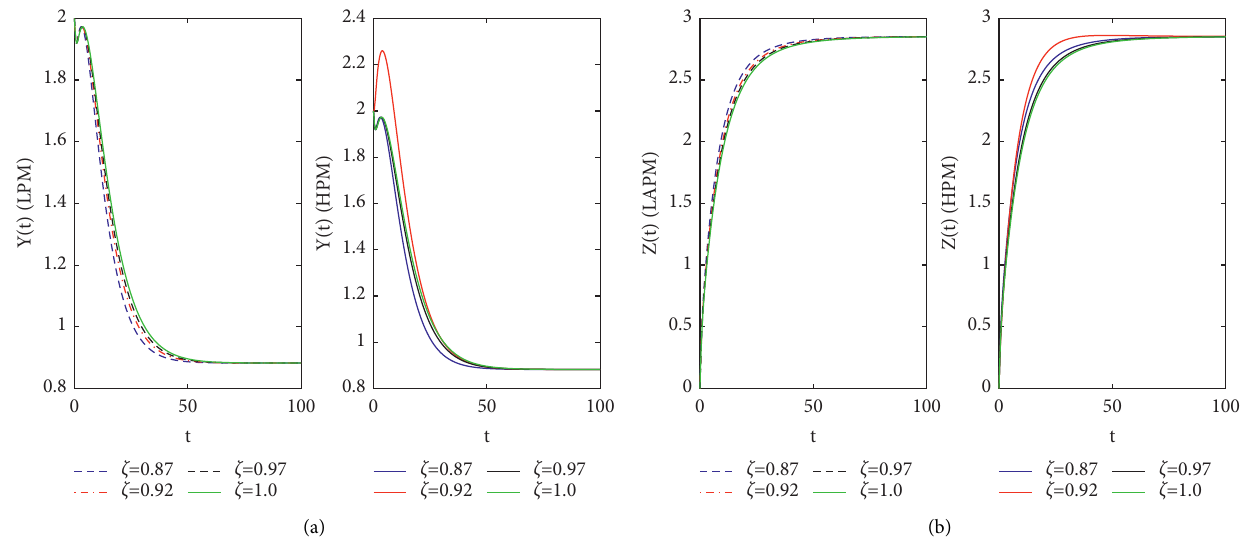
Figure 3: Comparison of LADM and HPM for the series solution of ( Y ( t ) , Z ( t )) for various arbitrary orders of the considered model (2). (a) Comparison of LADM and HPM for the series solution of Y(t) for various arbitrary orders. (b) Comparison of LADM and HPM for the series solution of Z(t) for various arbitrary orders.